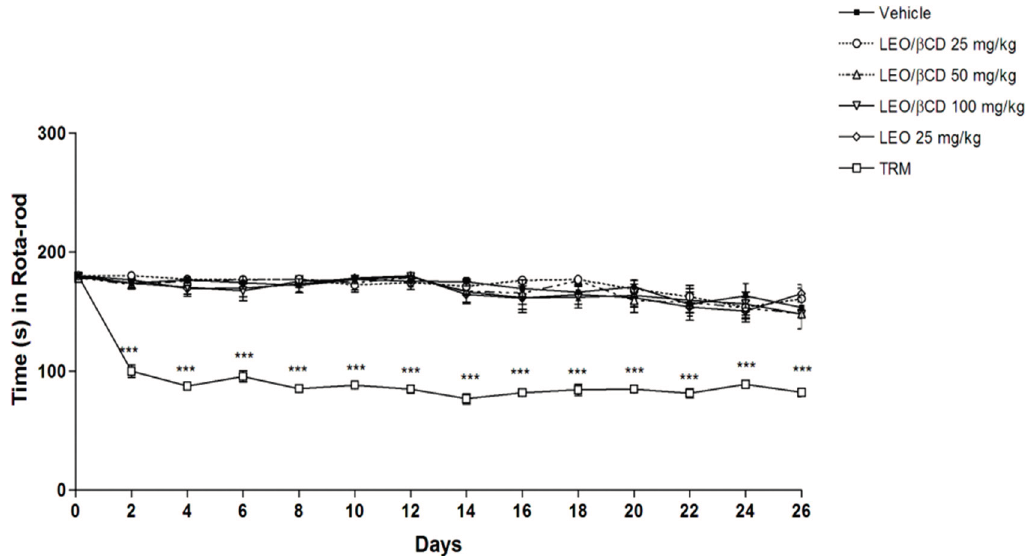
Figure 4. Effect of chronic administration of vehicle, Ocimum basilicum essential oil (LEO; 25 mg/kg, p.o.), Ocimum basilicum essential oil and β -Cyclodextrin (LEO- β CD; 25, 50 and 100 mg/kg, p.o.) or tramadol (TRM, 4 mg/kg) on grip strength test, fore-/hindlimb (4 paws). Bars represent the means (SEM) grip strength measurement (in grams of force) averaged across 3 trials. *** p < 0.001 vs. control group (ANOVA followed by Bonferroni test).